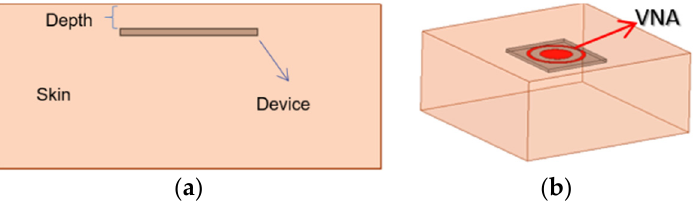
Figure 2. Simulation and measurement configurations. ( a ) The side view. ( b ) The 3-D view. Because it is impossible to use human tissues for experiments, ground pork with about 27% of fat and 0.013 moles of saline is used as the tissue material at room temperature. The pork is packed in a cube of 100 × 100 × 50 cm 3 as a phantom. The cube is sealed with multiple layers of plastic wrap to keep moist. Disagreements on the tissue dielectric characteristics (permittivity and conductivity) are expected. Verification for the discrep-